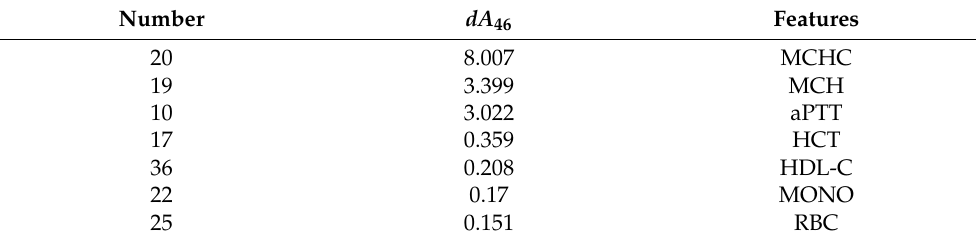
Table 6. The seven features found to be most important in the diagnosis of